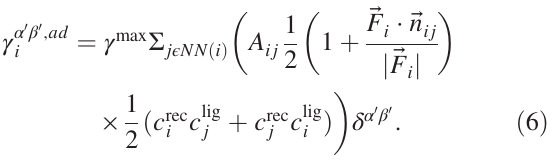
FIG. 1. (a) Two interpenetrating cells i and j with radii R R , respectively. The distance between the centers of the two cells j − r is j r , and their overlap is h . (b) Force on cell i due to j , F i j j ij 4 μ m using mean values of the elastic modulus, R for R i ¼ j ¼ Poisson ratio, and receptor and ligand concentration (see Table I). F is plotted as a function of the distance between the centers of ij the two cells. The inset shows the region where F − r ≥ R 8 μ m, the cells are no longer in R When j r i j j i þ j ¼ 0 contact and, hence, F ij ¼